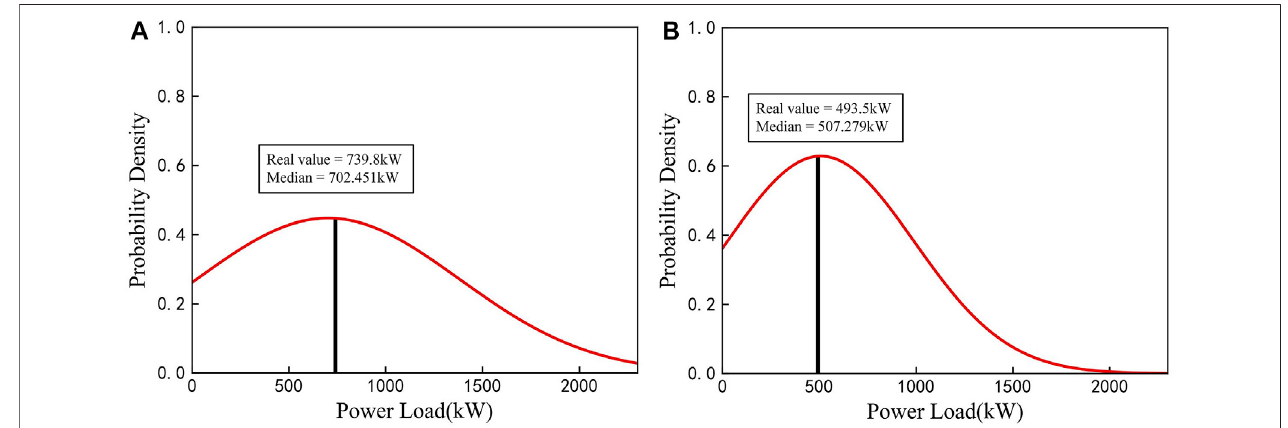
FIGURE 9 | ConvLSTM-MDN model predictive distribution and real values for a day at (A) 8:45 and (B) 23:00 in experiment 2.